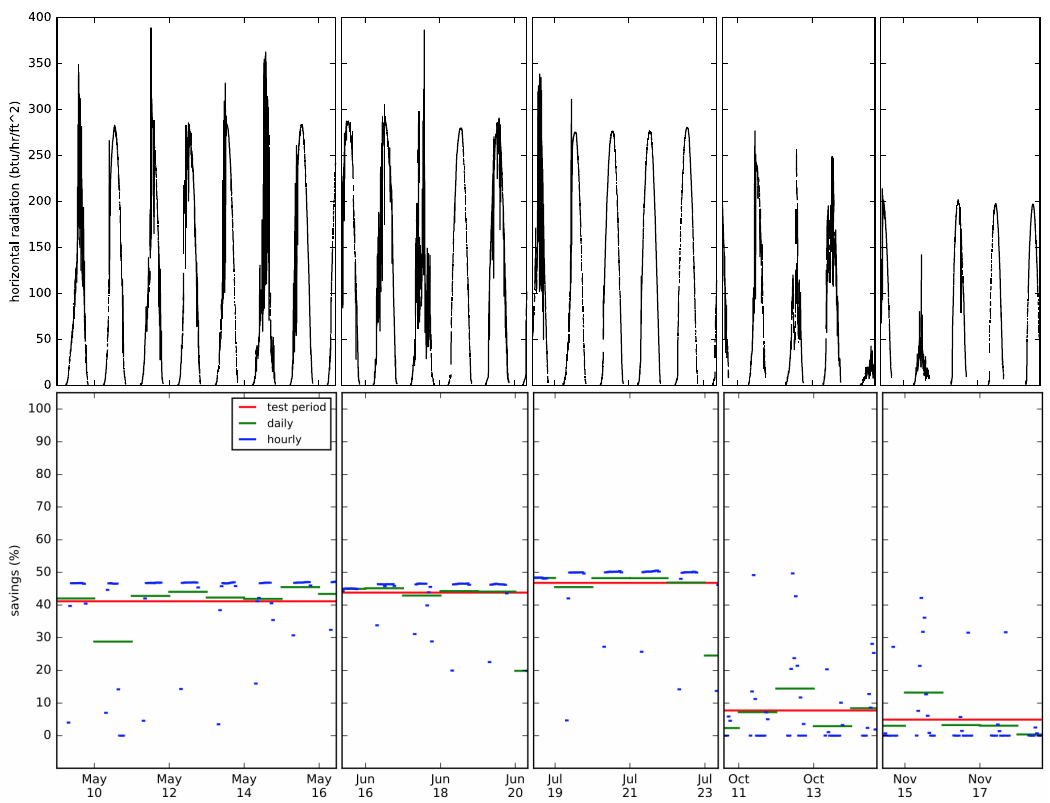
Figure 3. Exterior horizontal radiation measured at the test facility is plotted along with hourly, daily, and test period lighting energy savings for each seasonal test. This test configuration includes a south-facing window wall, for which low sun angles in the fall and winter correspond to the automated shades closing, reducing available daylight for dimming. Note that the cloudier days in October and November with the least horizontal radiation correspond to roller shade retraction allowing diffuse light in and actually increasing electric light dimming.